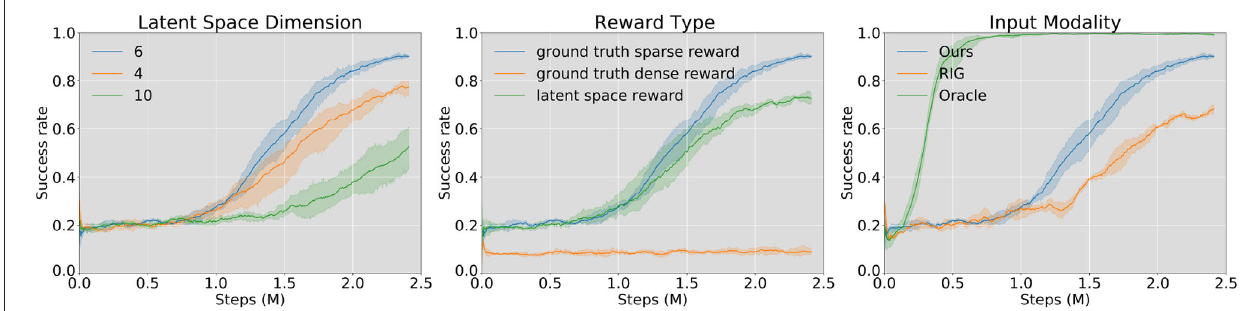
FIGURE 7 | Learning results in simulation, success rate vs. training steps. From left to right: model trained with different VAE latent space dimensions (left), reward functions (middle), and input modalities (right). Through experiments, we find that the best performance comes from the model with latent space dimension d z = 6, trained with the ground truth sparse reward function. “Oracle” in the right figure is the training results of a state-based agent on one single object (cylinder, d = 4 cm ). “RIG” (Nair et al., 2018) takes only the image as input. We set random explorations at the first 200 episodes for each training process, leading to an initial success rate of around 20% for each learning curve.